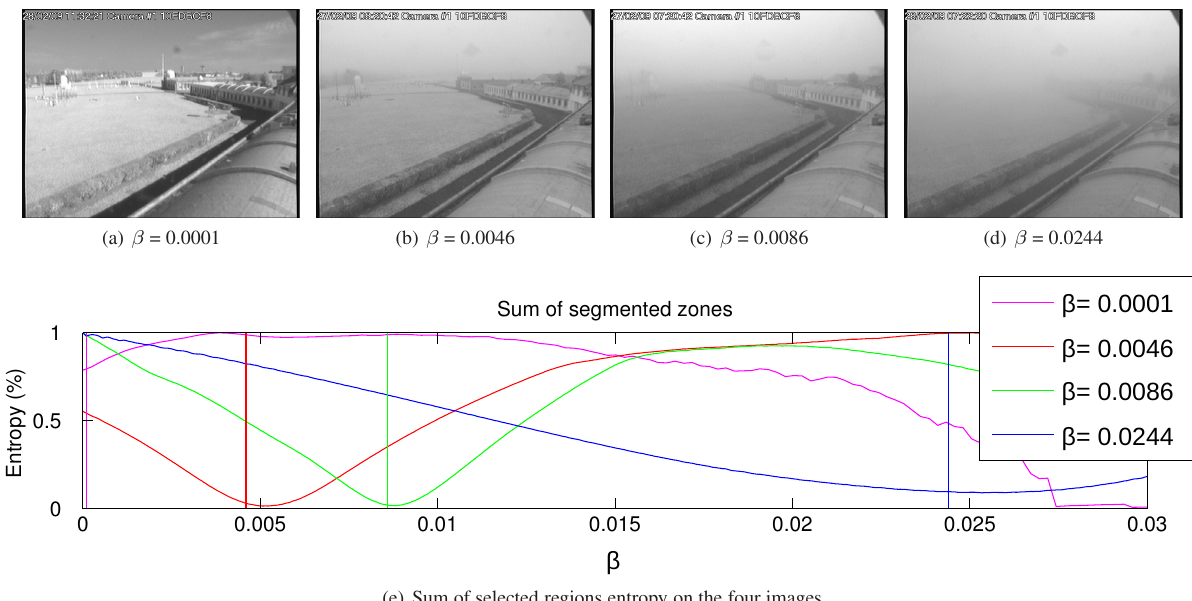
Figure 3: Normalized total entropy versus β on the same scene with different weather conditions. The ground-truth β measured with a visibility-meter are shown ( 0 . 0001 , 0 . 0046 , 0 . 0086 and 0 . 0244 ) as vertical lines.